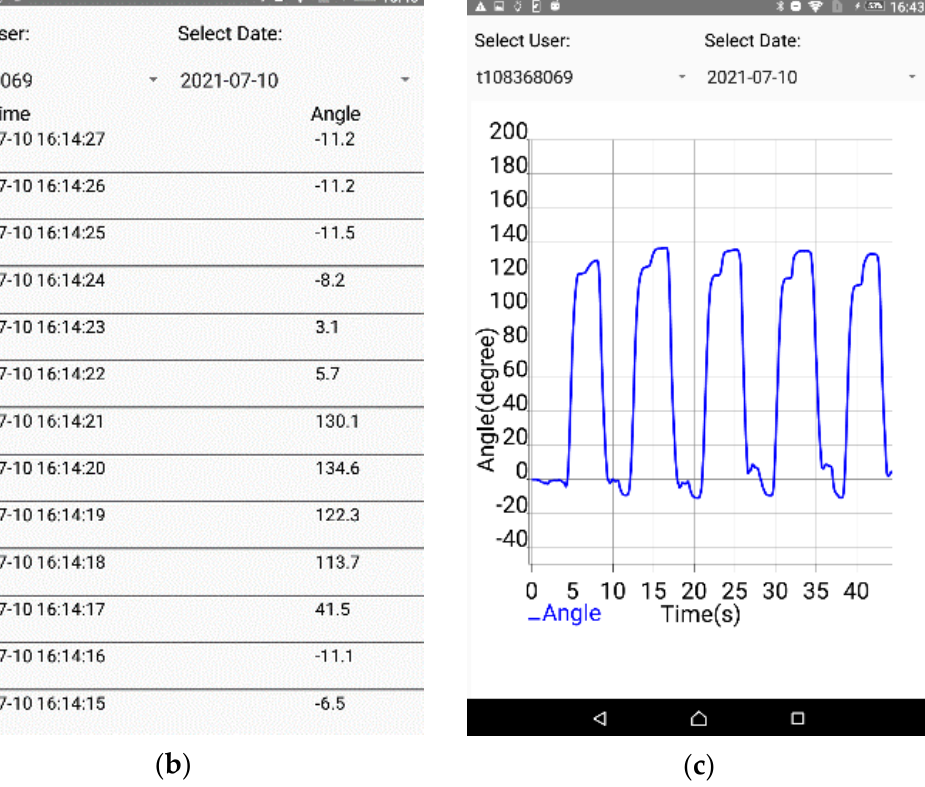
Figure 6. User interface of the ROMSS app. ( a ) Display current rehabilitation information, upload rehabilitation data, and browse historical records. ( b ) History query in the column. ( c ) History query in waveform.